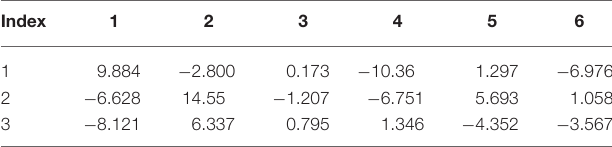
TABLE 7 | Internal strain tensor (Voigt notation) of Br 2 for displacements in x, y, z (eV/Å).